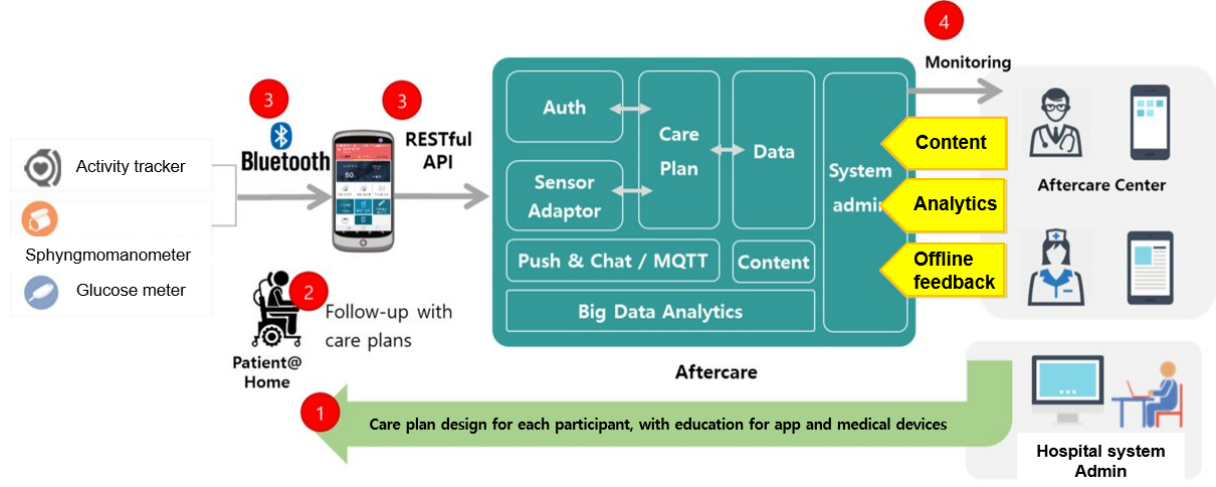
Figure 1. Schematic view of Smart Aftercare. MQTT: message queue for telemetry transport.